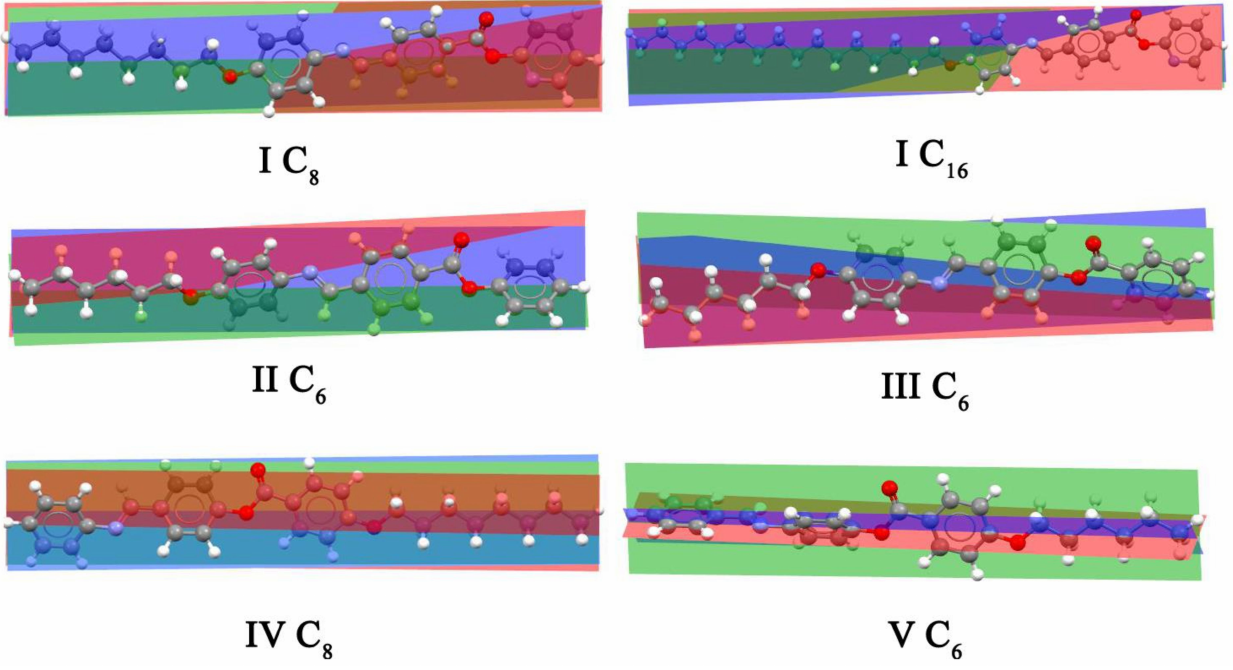
Figure 6. Estimated geometrical structure and twist angles of compounds I C 8 , I C 16 , II C 6 , III C 6 , IV C 8 , and V C 6